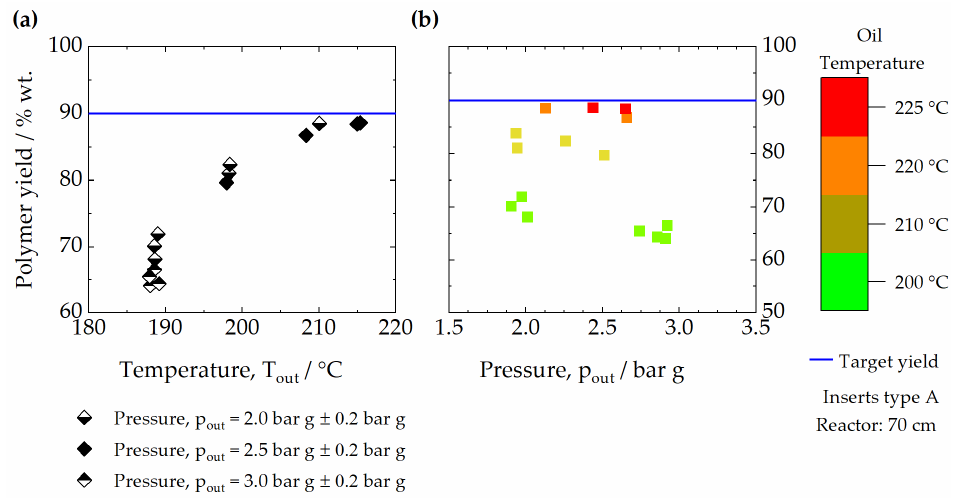
Figure 5. Polymer yield for ( a ) different reaction temperatures and ( b ) different pressures at the reactor outlet, with mass flow rates of 3.15 kgh − 1 ± 0.1 kg h − 1 . The color scale refers to the oil set temperature.